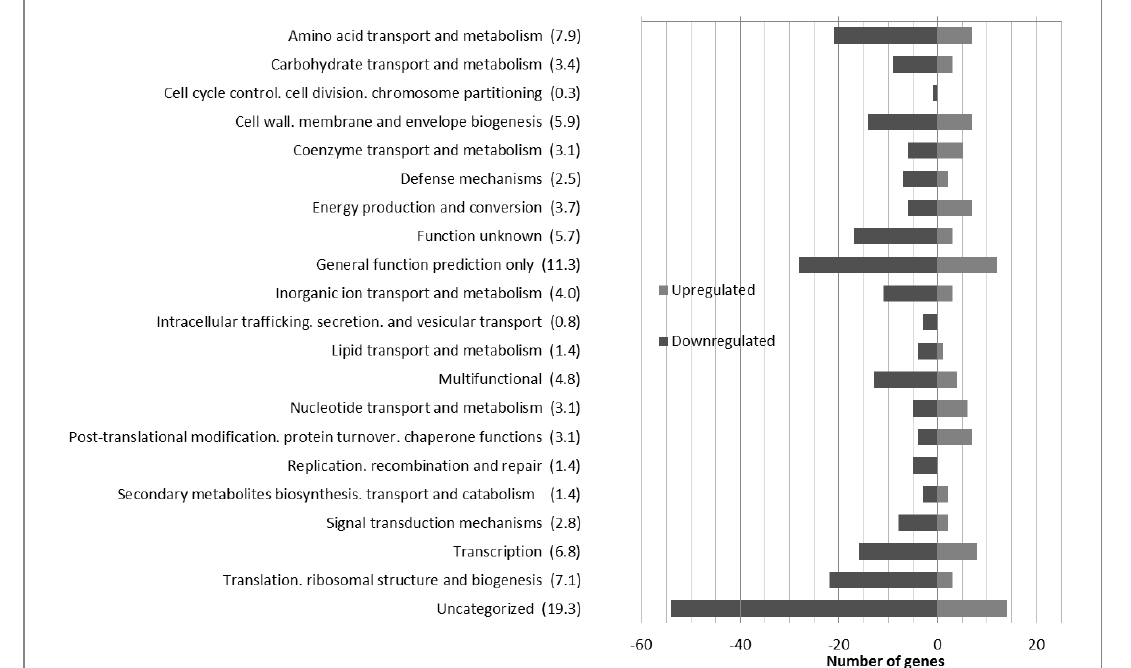
Figure 1. Hydroxytyrosol-regulated genes from Lactobacillus plantarum WCFS1 classified by functional categories. The number of upregulated and downregulated genes (percentage in parentheses) in the presence of 10 mM hydroxytyrosol is shown for each category.